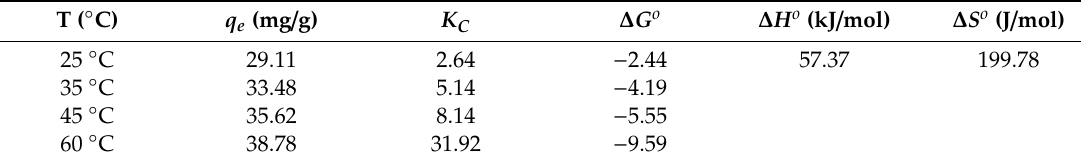
Figure 6. Plot of ln K C vs . 1/T . Table 4. Thermodynamic